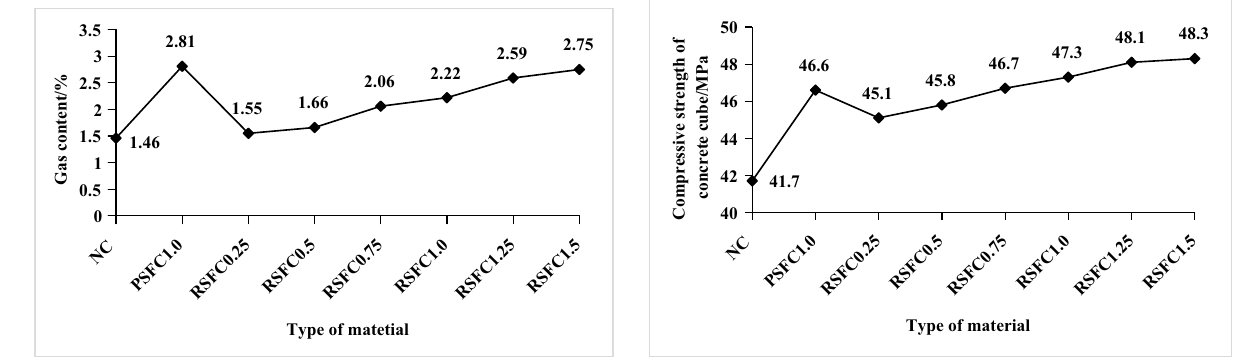
Figure 9: Air content of concrete mixture. Figure 10: Cube compressive